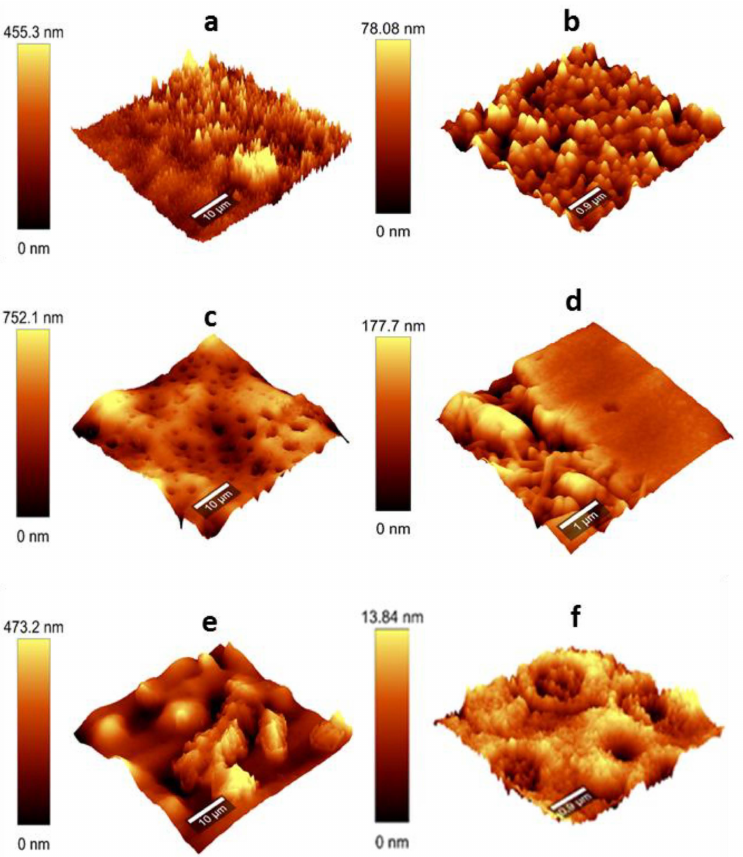
Figure 1. Images of 3D AFM surface topology of the glass lamina coated with CL and LS (CL + LS) ( a , b ) and with LS and CL (LS + CL) ( c , d ) with intermediate drying of deposited layers and with CL and LS (CL + LS) ( e , f ) without intermediate drying of deposited layers. The size of images varied